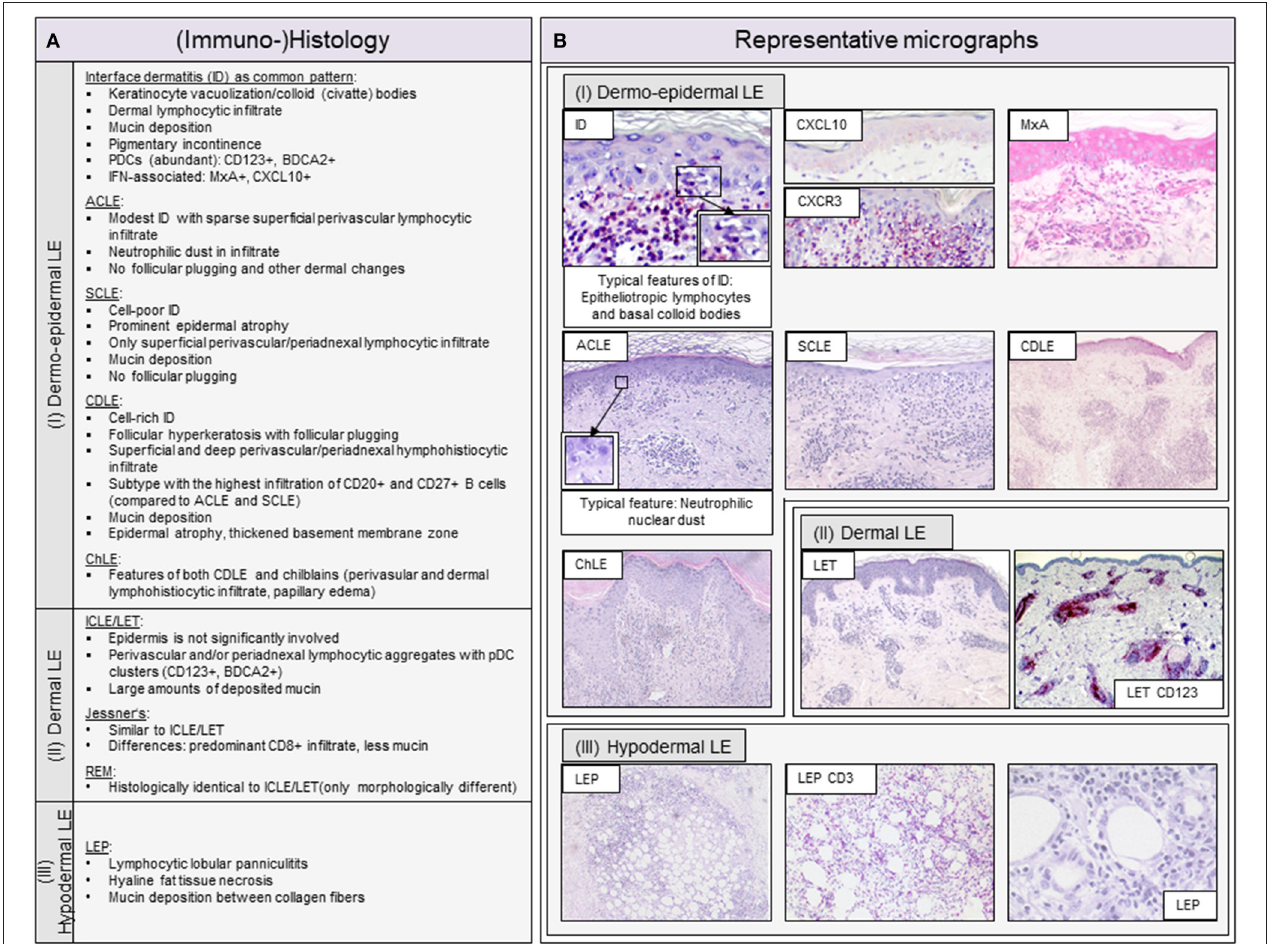
FIGURE 2 | Overview of typical histopathologic patterns observed in different cutaneous lupus erythematosus (CLE) subtypes. (A) Typical (immuno-)histologic findings of (I) dermo-epidermal lupus erythematosus (LE), (II) dermal LE and (III) hypodermal LE. Dermo-epidermal LE, presenting as interface dermatitis (ID) includes the morphologic variants acute cutaneous LE (ACLE), subacute cutaneous LE (SCLE) and chronic discoid LE (CDLE) among others. Dermal LE consists of intermittent cutaneous LE (ICLE), also named LE tumidus (LET), Jessner-Kanof lymphocyte infiltrate (Jessner’s), and reticular erythematous mucinosis (REM), however,